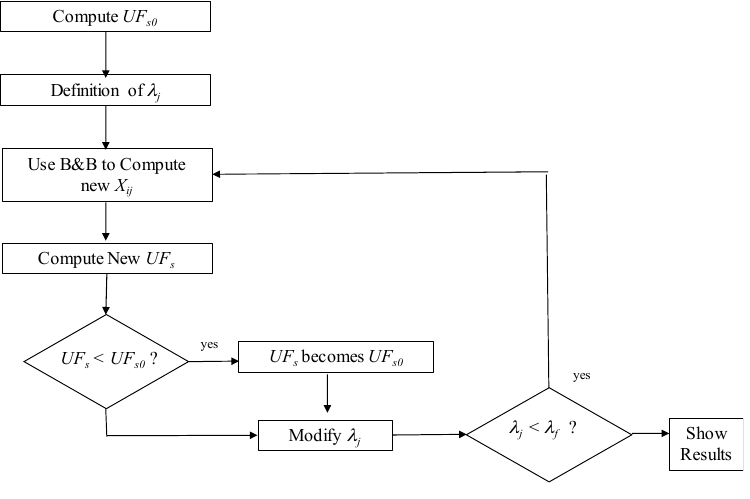
Figure 2. Flowchart of the proposed method.